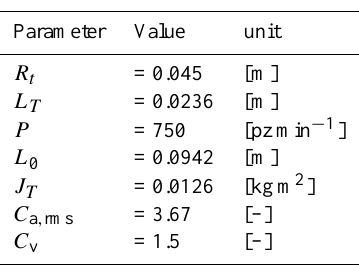
Table 2. Test case value.